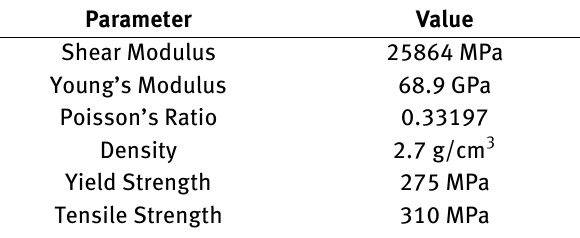
Table 6: Properties of the material Aluminum 6061